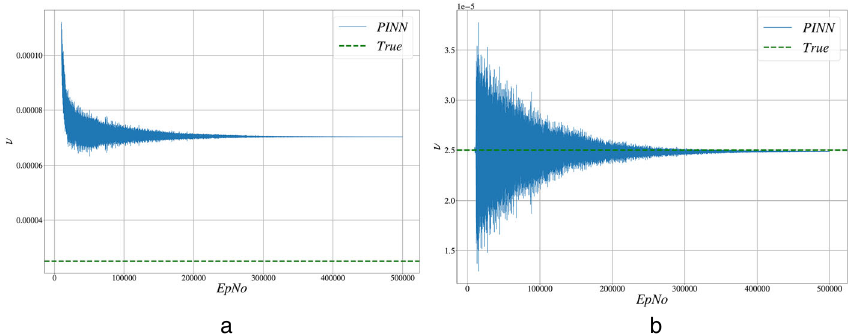
Fig. 14 The approximation of the physical viscosity by the PINN at each training epoch for the reduced setting N u = N p = N S = 60, Fig. 14a refers to the PINN based on the quadratic approximation of the convective term using a third order tensor and Fig. 14b corresponds to the PINN with the convective term being approximated as an output of the neural network (the approach adopted in this work). (a) The PINN with the convective term approximated as a quadratic product at the reduced level. (b) The PINN with the convective term approximated as an additional reduced output of the neural